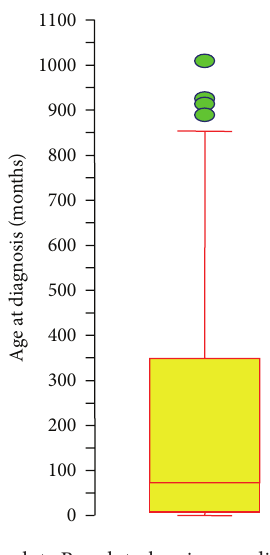
Figure 1: Age Boxplot. Boxplot showing median age (solid line within box) with borders of box representing 25th and 75th per- centiles with 95% confidence intervals. Circles indicate individual outliers, the oldest of which is 1008 months at diagnosis.